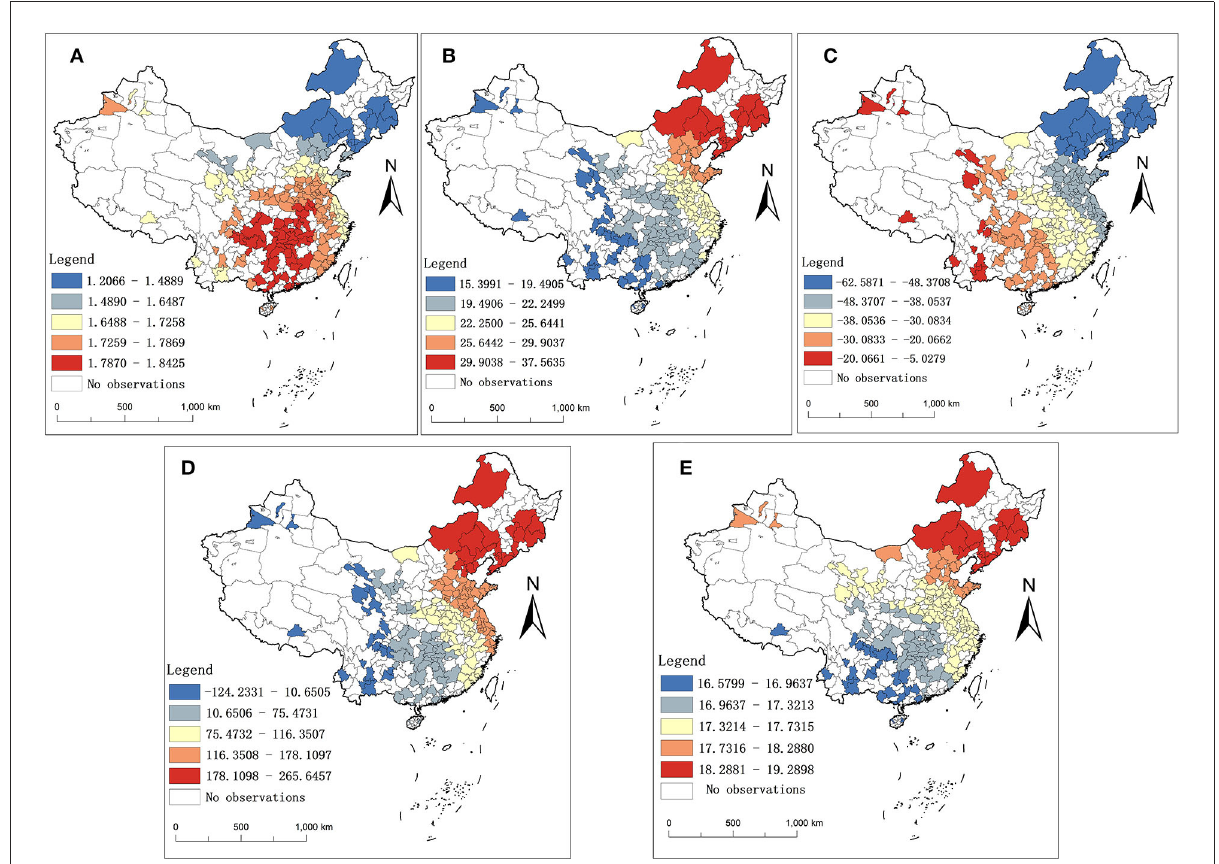
FIGURE4 Spatial distribution of the average coefficients for other explanatory variables. (A–E) represent the spatial distribution of the average coefficients of PM2.5, per capita consumption expenditure, economic density, population density, and number of medical beds,